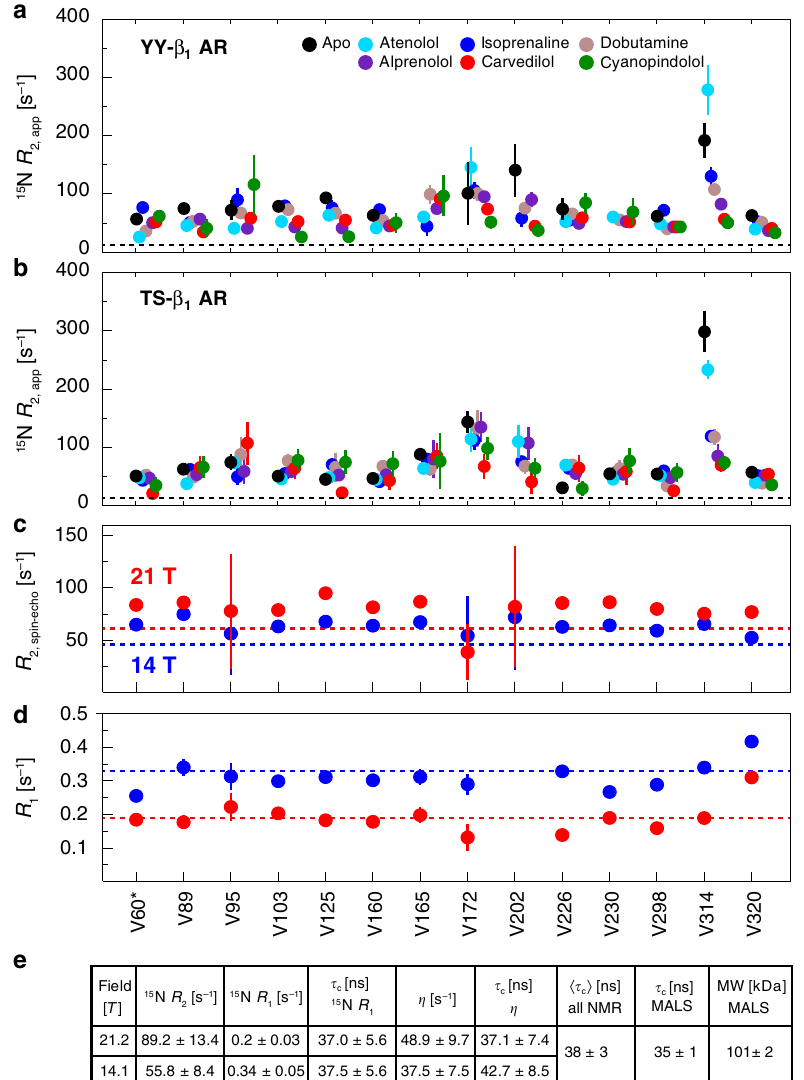
Fig. 2 15 N relaxation rates of YY- β 1 AR and TS- β 1 AR. a , b Residue-speci fi c 15 N apparent transverse relaxation rates R 2,app of 15 N-valine YY- β 1 AR and TS- β fi tting of the 1 H- 15 N TROSY spectra in the apo form and orthosteric binary complexes recorded at 304 K and 21 T (YY- β 1 AR derived from line shape or 19 T (TS- β 1 AR). Due to limited stability, the apo form of YY- β 1 AR was recorded at 294 K. Data are color-coded according to the ligand. The dashed lines represent theoretical TROSY 15 N R 2 rates for a rotational correlation time τ c of 38 ns. c , d Residue-speci fi c 15 N spin-echo transverse ( R 2,spin-echo ) and longitudinal ( R 1 ) rates of alprenolol-bound 15 N-valine TS- β 1 AR recorded at 304 K and 21 T (red) or 14 T (blue). Dashed lines represent theoretical R 2 and R 1 rates. The assignment of V60 is tentative and marked by an asterisk. Numerical data for a – d are provided in Supplementary Data 3. Error values were derived from Monte Carlo fi tting as indicated in Methods. e Average 15 N relaxation rates obtained from 1D experiments on 2 H (~60%)/ 15 N-labeled, alprenolol-bound TS- β 1 AR (Supplementary Fig. 3), molecular weight by MALS, and rotational correlation times τ c derived from NMR and